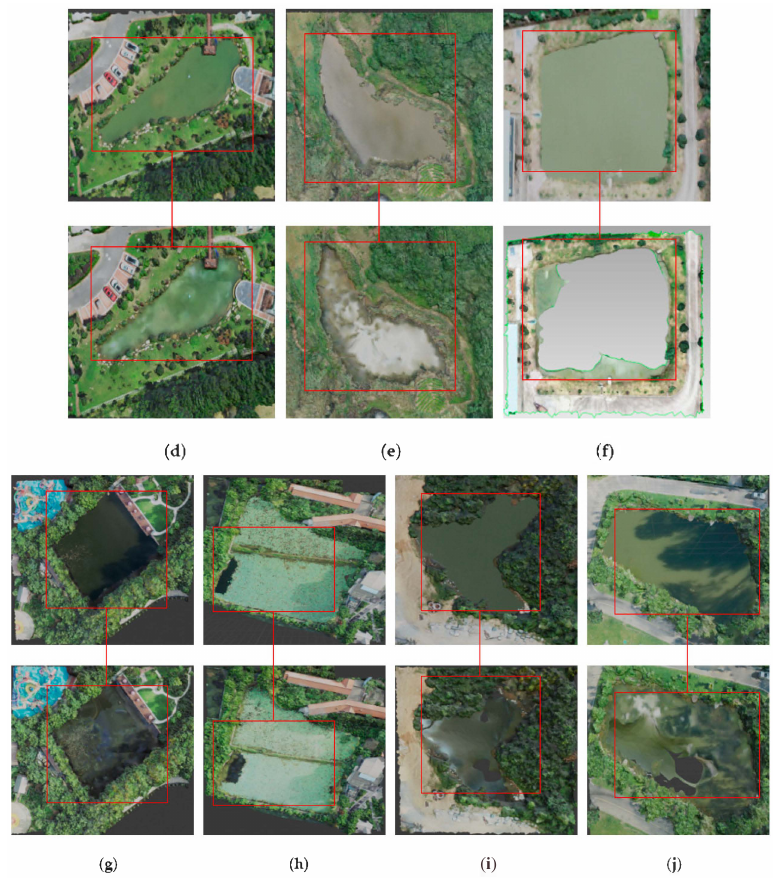
Figure 8. Results of water region reconstruction. ( a – j ) are the reconstruction results of water regions in model_01, model_02, model_03, model_04, model_05, model_06, model_07, model_08, model_09 and model_10, respectively. For each result, the upper image is the reconstruction result, the bottom image is the original 3D model of photography, and the framed regions are the effects of local alignment.